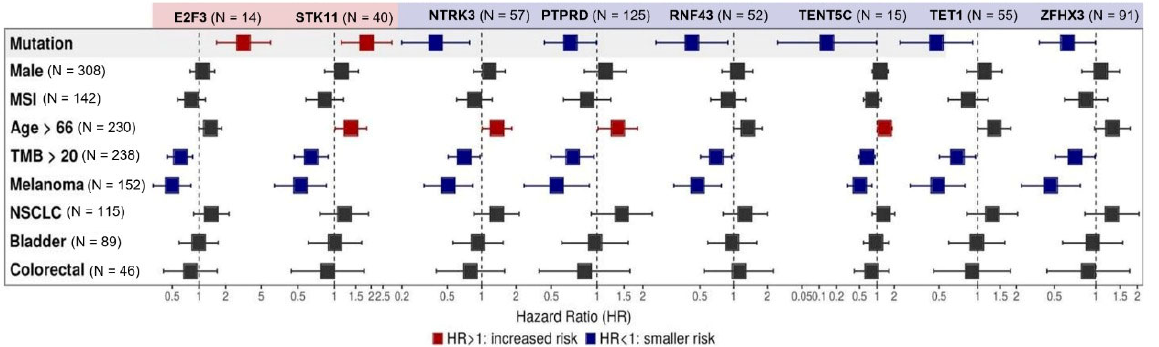
Figure 2. Multivariate analysis of individual gene alterations in high TMB patients. Forest plot for overall survival (OS) in multivariate analysis. Adjustment variables included TMB under or above the median of 20 mut/Mb, sex, median age, microsatellite instability (MSI) status, and tumor types (non ‐ small cell lung cancer (NSCLC), melanoma, bladder cancer, and colorectal cancer). Mutations in STK11 (N = 40, HR 1.84 (95% CI, 1.14 ‐ 2.97) and E2F3 (N = 14, HR 3.17 (95% CI, 1.58–6.38]) were related to worse survival ( p < 0.05), while mutations in NTRK (N = 57, HR 0.39 95% CI, 0.20–0.78), PTPRD (N = 125, HR 0.67 95% CI, 0.45–0.99), RNF43 (N = 52, HR 0.42 95% CI, 0.2015–0.89), TENT5C (N = 15, HR 0.14 95% CI, 0.02–0.98), TET1 (N = 55, HR 0.48 95% CI, 0.25–0.91), and ZFHX3 (N= 91, HR 0.62 95% CI, 0.39–0.99) were associated with better OS. Melanoma histology and TMB above the median TMB of the cohort (20 mut/Mb) endowed patients with better OS ( p < 0.05). MSI status, age, and gender did not have a consistent statistically significant effect on OS.